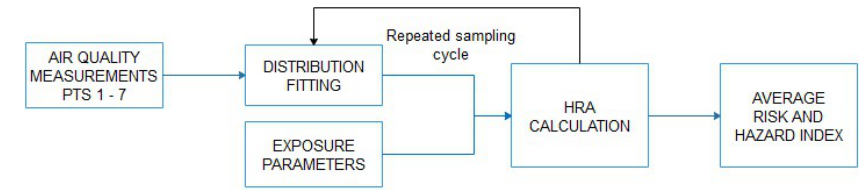
Figure 1. Scheme of the operational model for health risk analysis.